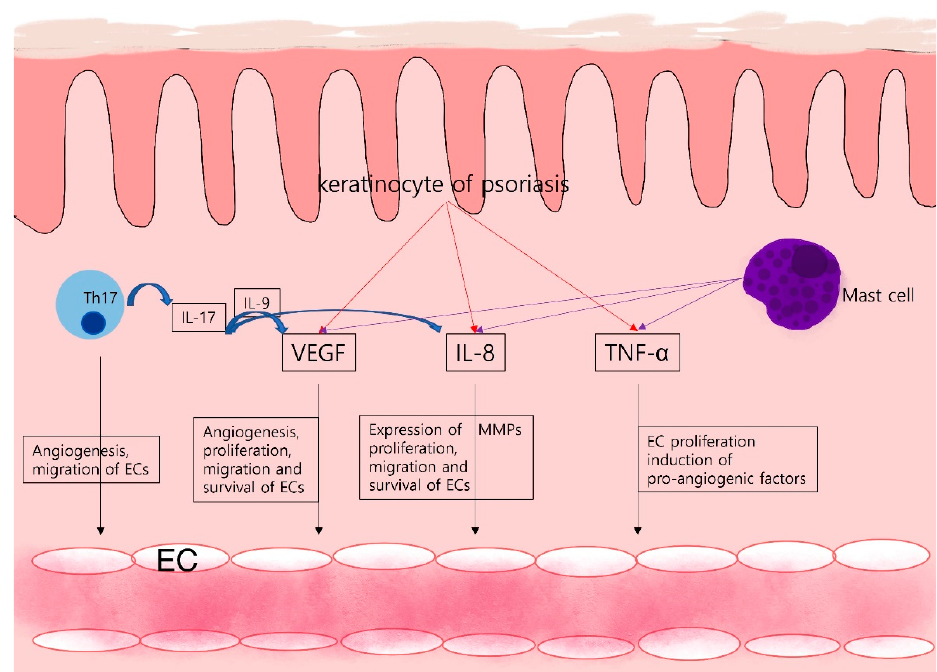
Figure 1. Angiogenesis in psoriasis: Th17 cells of psoriasis provoke angiogenesis through IL-17 production. In addition to angiogenesis promotion, expression of other angiogenic factors like VEGF and IL-8 is upregulated by IL-17. Keratinocytes, immune cells like mast cells, secrete a variety of pro-angiogenic factors and cytokines that activate and maintain the inflammatory skin condition of psoriasis.